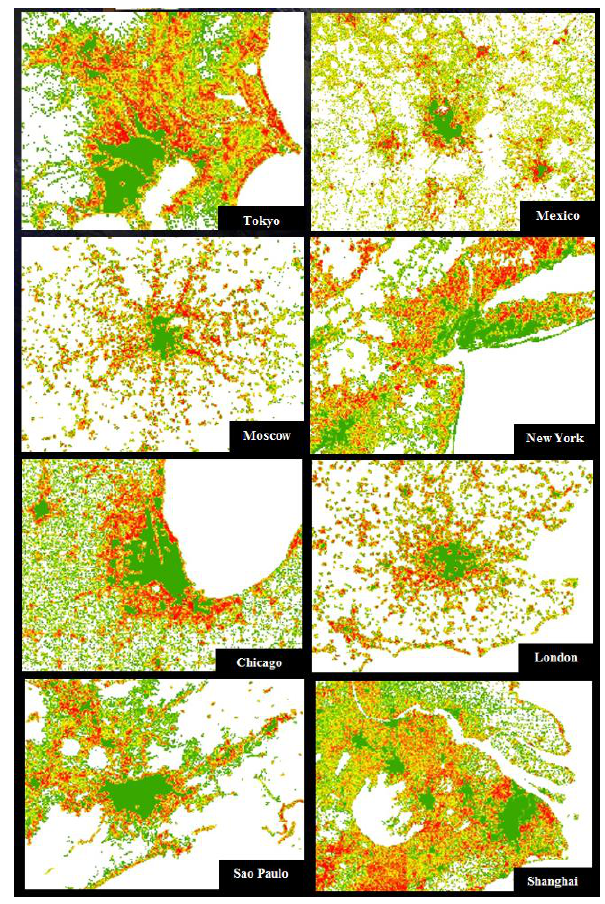
Figure 6.The Urban Entropy The spatial distribution of the entropy of the patches of artificialized land in the areas studied shows how there is a greater fragmentation of urbanization in the metropolitan periphery (red color in the images, see figure 6)while in urban centers, subcenters and rural areas (green in images) the entropy or complexity is lower . The explanatory models of the spatial distribution of entropy show a clear quadratic structure, maximum at the intermediate distances that characterize significant urban sprawl processes.